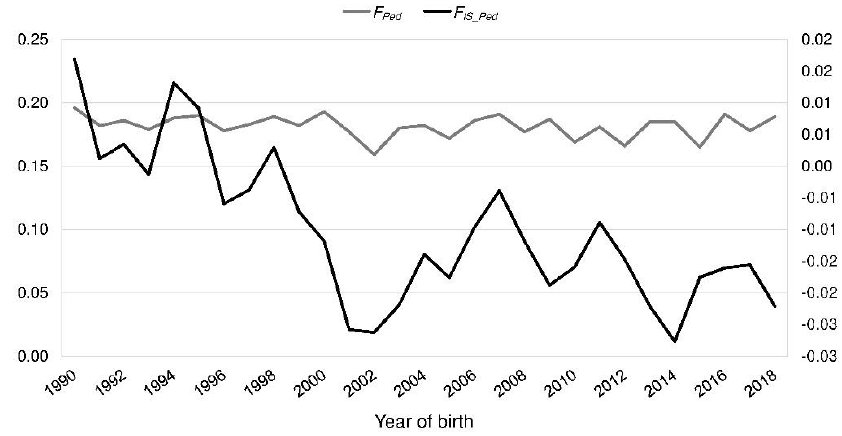
Figure 3. Inbreeding coefficient ( F Ped ) and fixation index F IS_Ped by the year of birth of the Polish Lowland Sheepdog reference population.